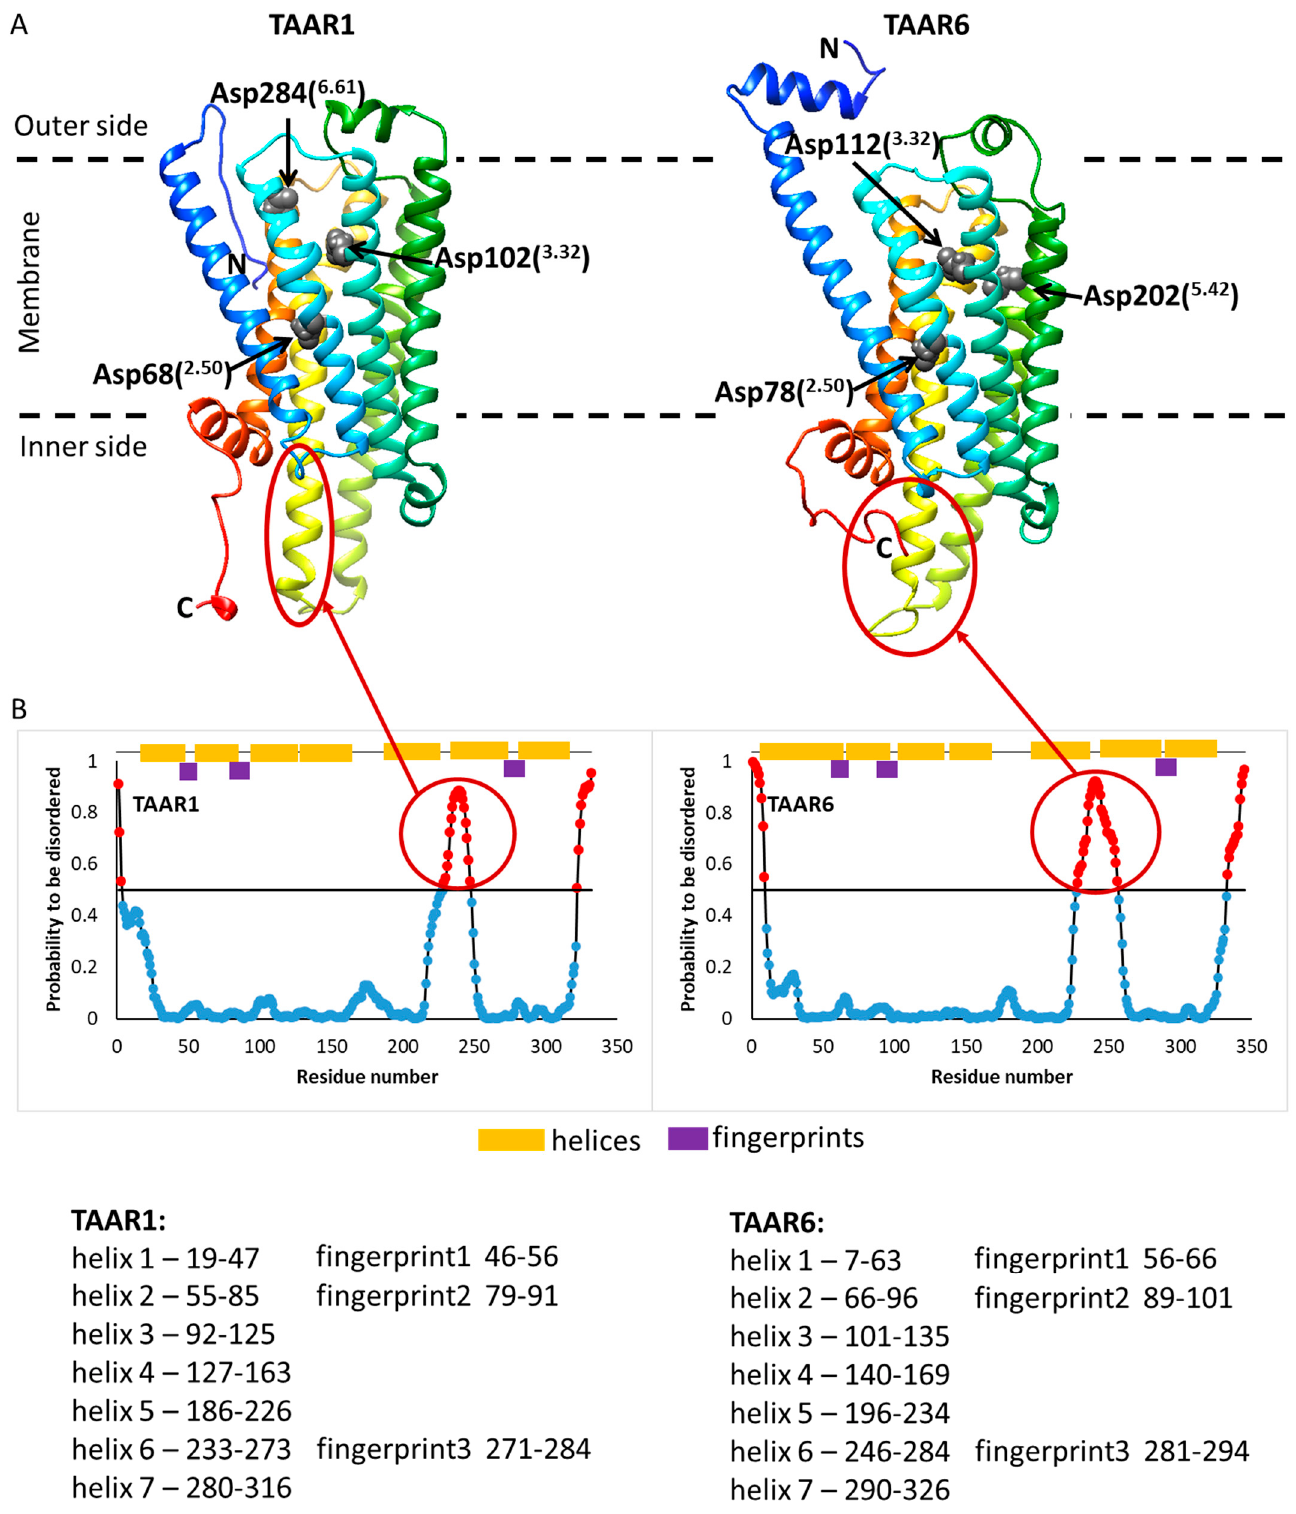
Figure 3. Spatial structures of the TAAR1 and TAAR6 receptors. Amino acid residues Asp68( 2.50 ), Asp102( 3.32 ), Asp284( 6.61 ) for TAAR1 and Asp78( 2.50 ), Asp112( 3.32 ), Asp202( 5.42 ) for TAAR6, which are probably included in the active center of these receptors, are highlighted in gray ( A ). Disordered regions were calculated using the IsUnstruct program [43] ( B ). Numeration of helices is given according to model 1 for both TAARs.